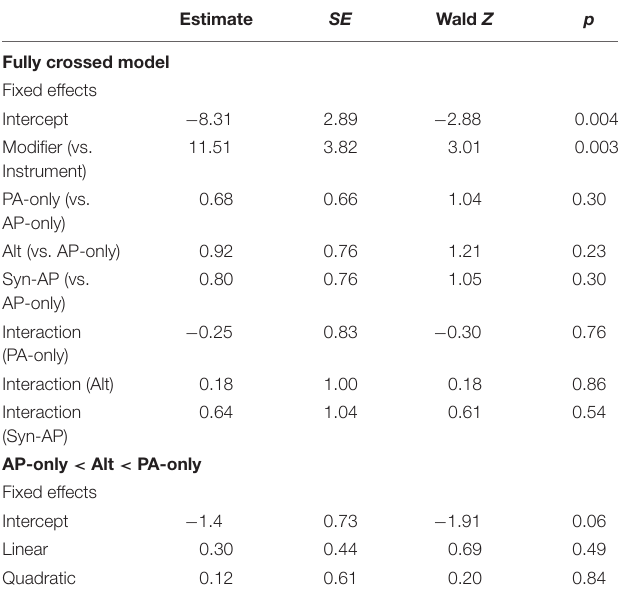
TABLE 4 | Mixed models of the likelihood of a PA order response in Experiment 3. Estimate SE Wald Z